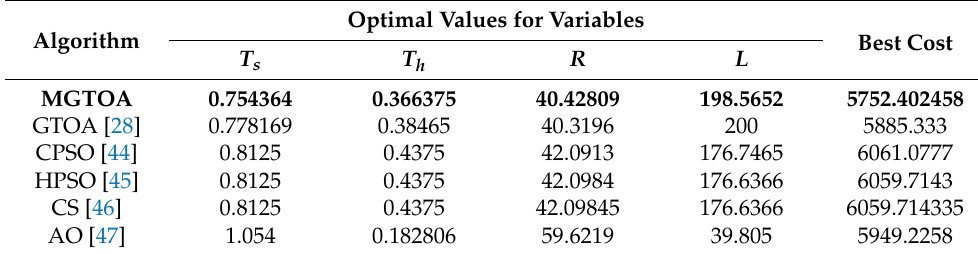
Table 11. Experimental results of Pressure Vessel Design.